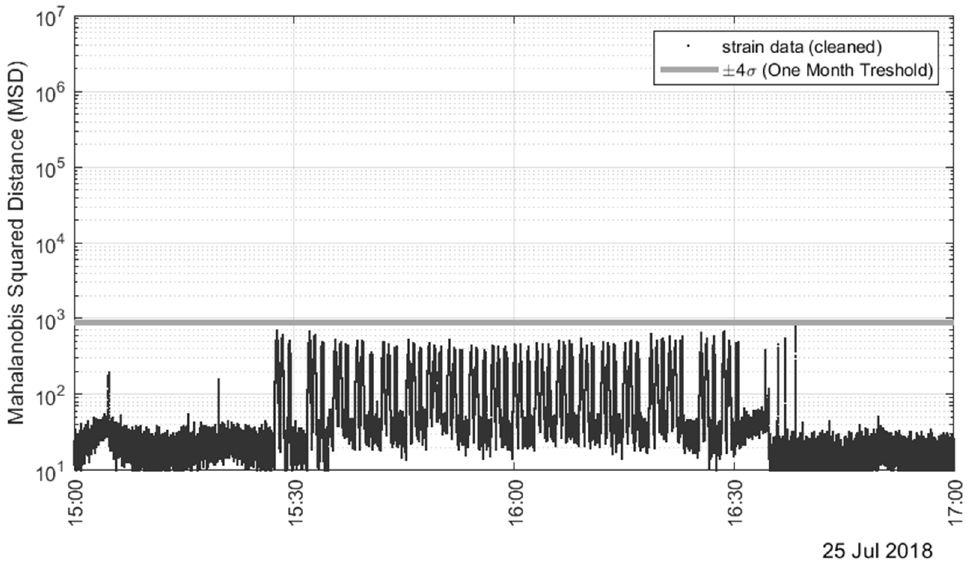
Figure 16. Close-up view of the Mahalanobis squared distance during the truck test.